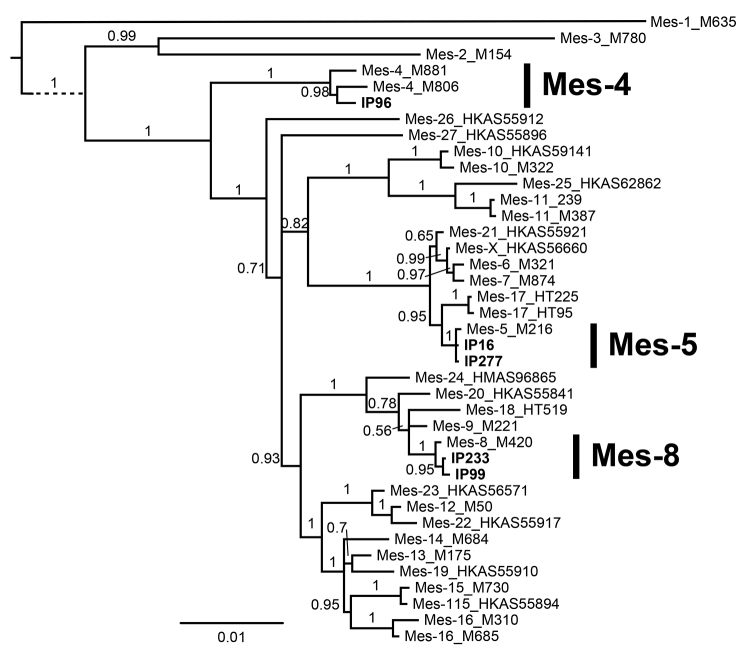
Bayesian phylogeny inference tree based on five-gene concatenated alignment from selected accessions of the Esculenta Clade. Posterior probabilities (PP) are shown above branches, splits with PP < 50% were collapsed.